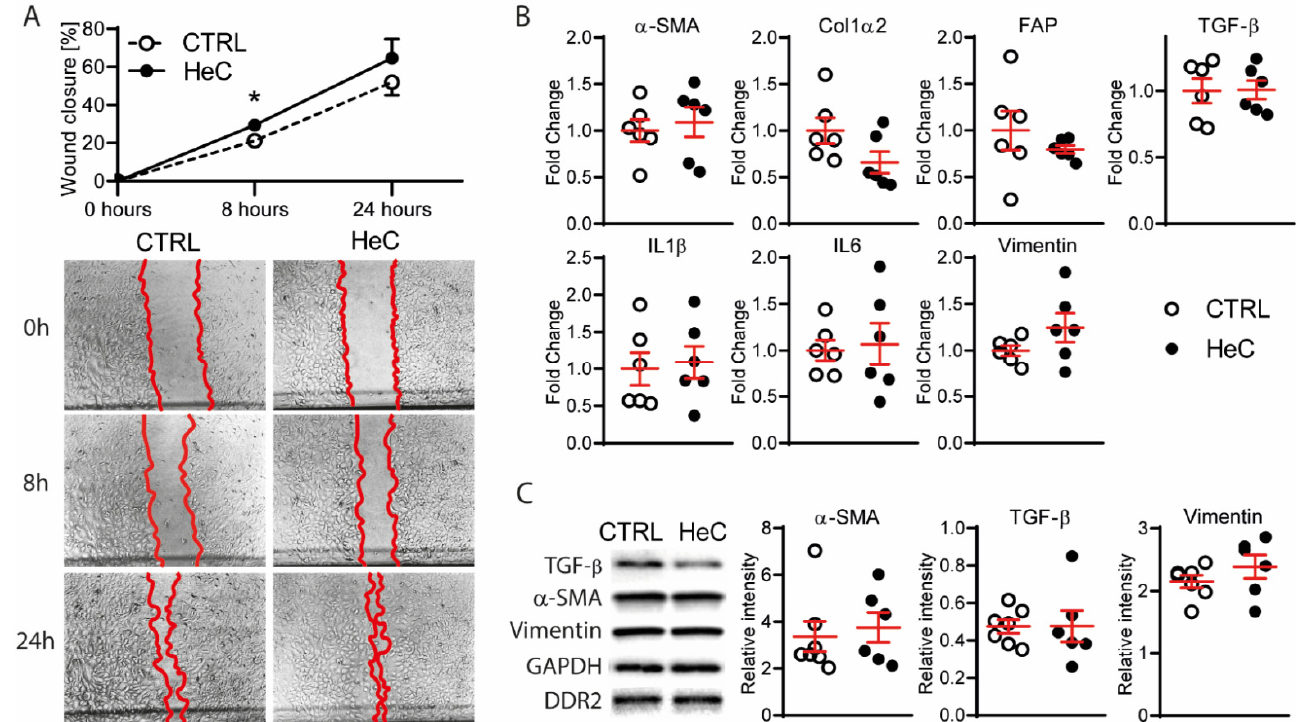
Figure 1. HeC induces fibroblast migration, but not myofibroblast transformation or inflammation; ( A ) Migration of CTRL and HeC NRCFs after scratch stimuli with representative images 0, 8 and 24 h after scratch with 5 × magnification; ( B ) qPCR analysis of markers of myofibroblast transformation ( α -SMA , Col1 α 2 , FAP and TGF- β ) and inflammatory markers ( IL1 β and IL6 ) of CTRL and HeC NRCFs. Vimentin was used as a control for fibroblast phenotype; ( C ) WB representative bands and relative protein expression of α -SMA and Vimentin compared to DDR2 and TGF- β compared to GAPDH in CTRL and HeC NRCF cells; n = 4–7. Results are represented as mean ± SEM; * p < 0.05 vs. CTRL.